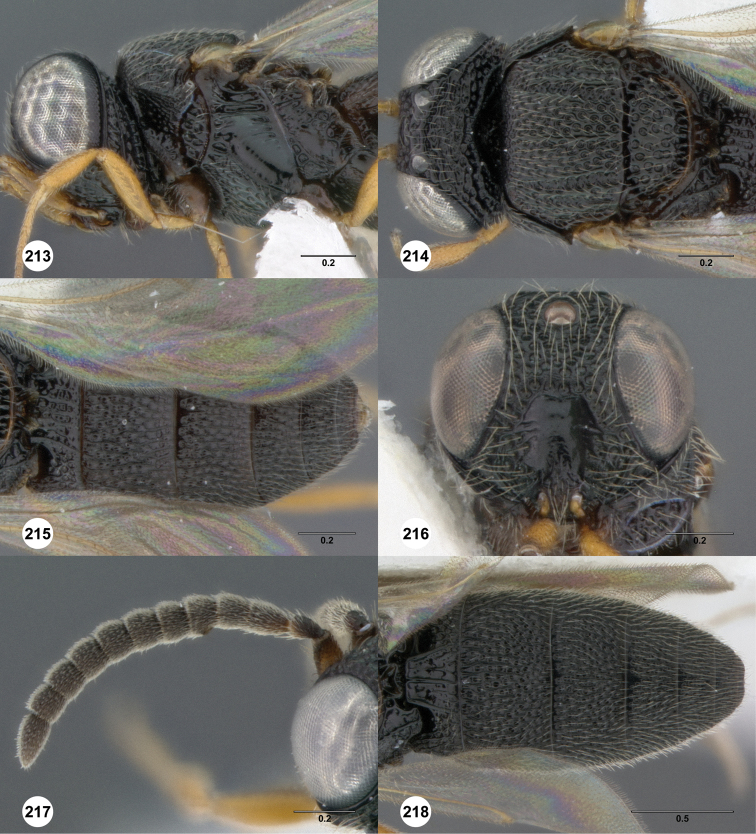
Oxyscelio nigricoxa (Dodd), female (OSUC 462599) 213 Head and mesosoma, lateral view 214 Head and mesosoma, dorsal view 215 Metasoma, dorsal view. Female (QDPC 0-165685) 216 Head, anterior view. Paratype male (OSUC 438140) 217 Antenna 218 Metasoma, dorsal view. Morphbank69